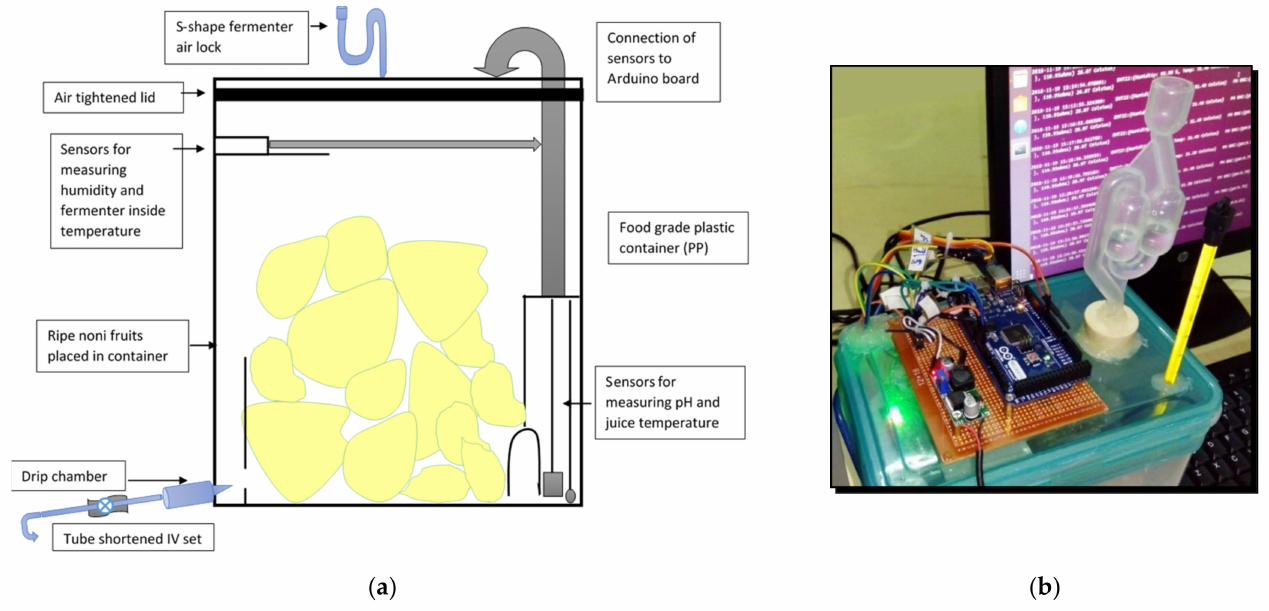
Figure 1. The measurement of the physical properties with traditional fermentation. ( a ) A schematic diagram of the experimental setup to monitor the physical property variation during the traditional fermentation of noni juice. ( b ) Arduino MEGA 2560 microcontroller board connected with sensors and attached to the top surface of the